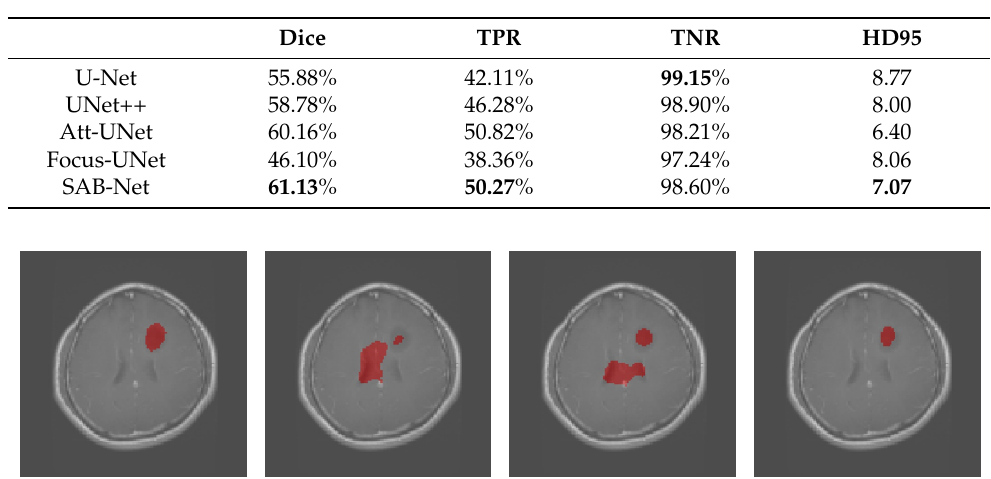
Table 5. Segmentation results obtained on the Colonoscopy dataset.